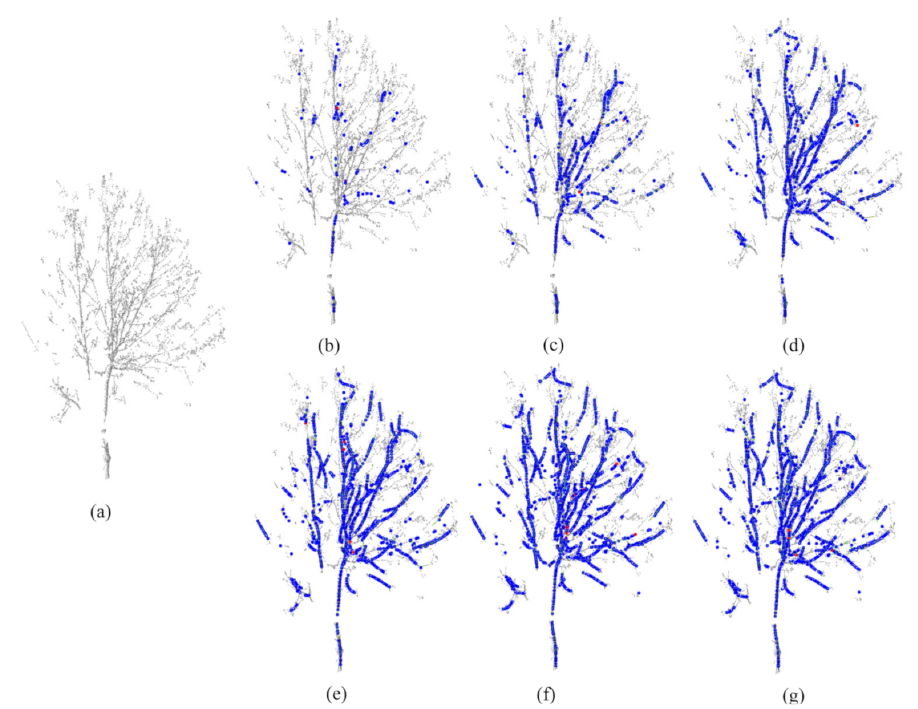
Figure 5. The initial skeleton points extracted under different penalty strength µ values, the blue points are the initial skeleton points, and the gray points are the original point cloud. ( a ) Initial point clouds; ( b ) µ = 0; ( c ) µ = 0.1; ( d ) µ = 0.2; ( e ) µ = 0.3; ( f ) µ = 0.35; ( g ) µ =